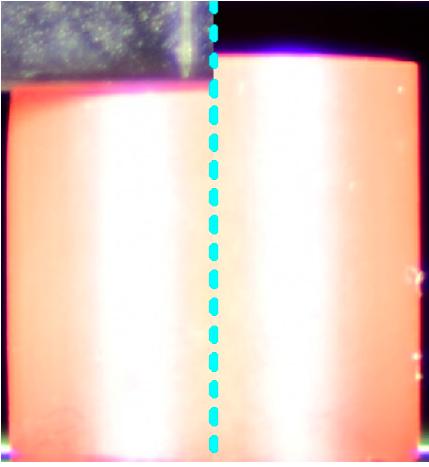
Figure 7. Compressed sample ( left side), uncompressed sample ( right side). Sample dimensions r = 5 mm; h = 10 mm; sample quantity during test: 4.